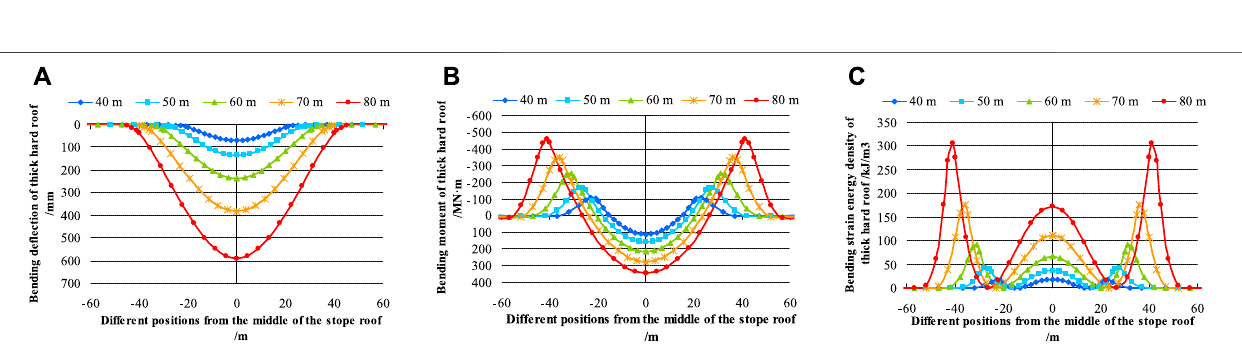
FIGURE5| Mechanicalin fl uencecharacteristicsoftheminingsuspensionspanontheminingbearingcapacityofthethickhardroof. (A) Distributioncharacteristics of bending de fl ection. (B) Distribution characteristics of stressed bending moment. (C) Distribution characteristics of elastic energy accumulation.